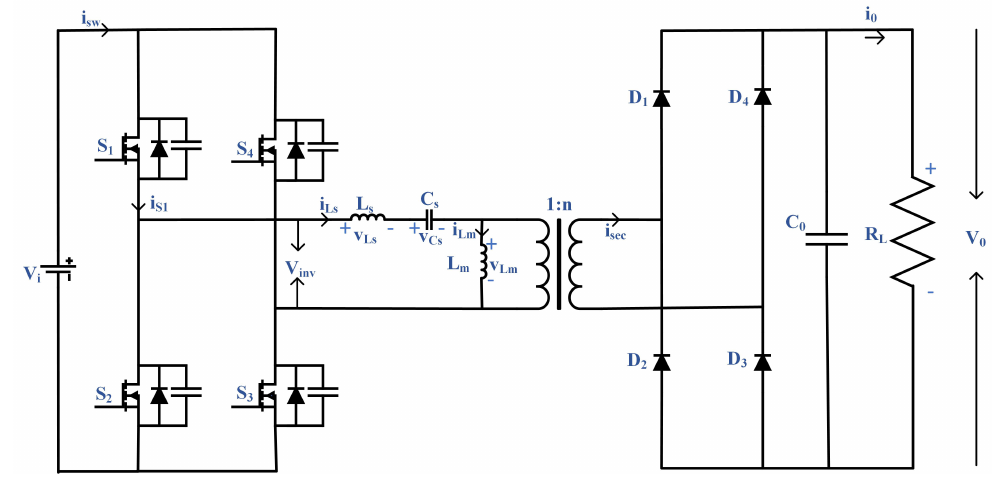
Figure 1. Full-bridge LLC resonant